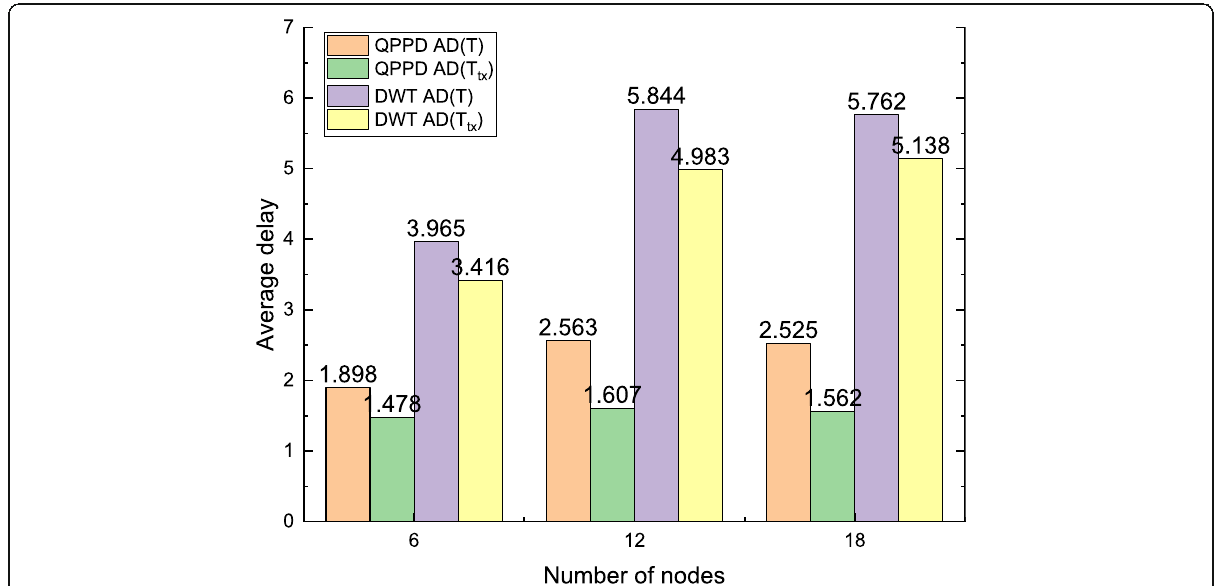
Fig. 38 The total volume of data randomly changes from 0 to 12; the average delay of high priority